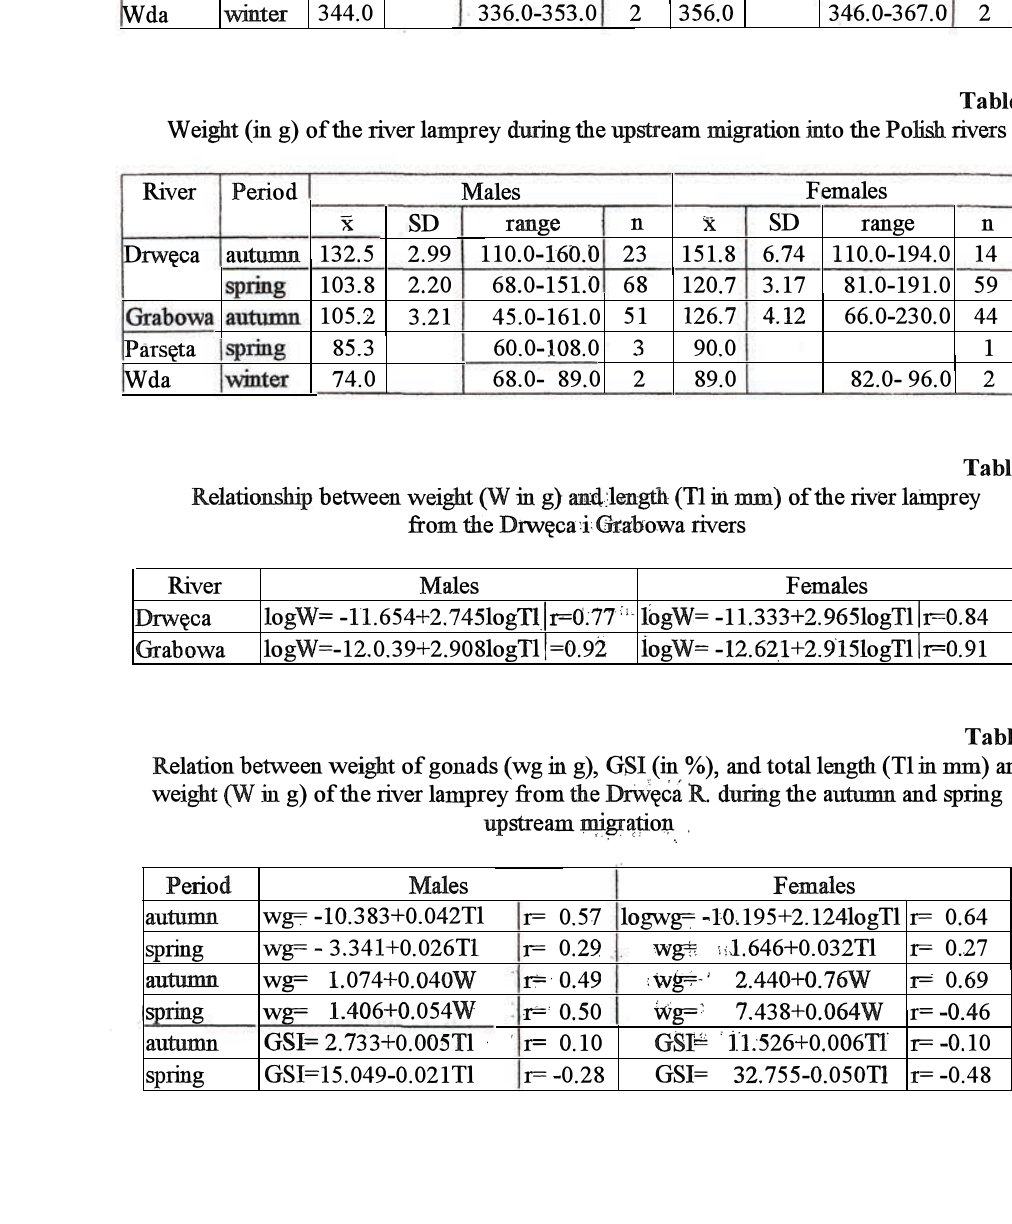
Relation between weight of gonads (wg in g), GSI (in % ), and total length (Tl in mm) and weight (W in g) of the river lamprey from the Drwyca ll. during the autumn and spring upstream nµgrii:tioµ